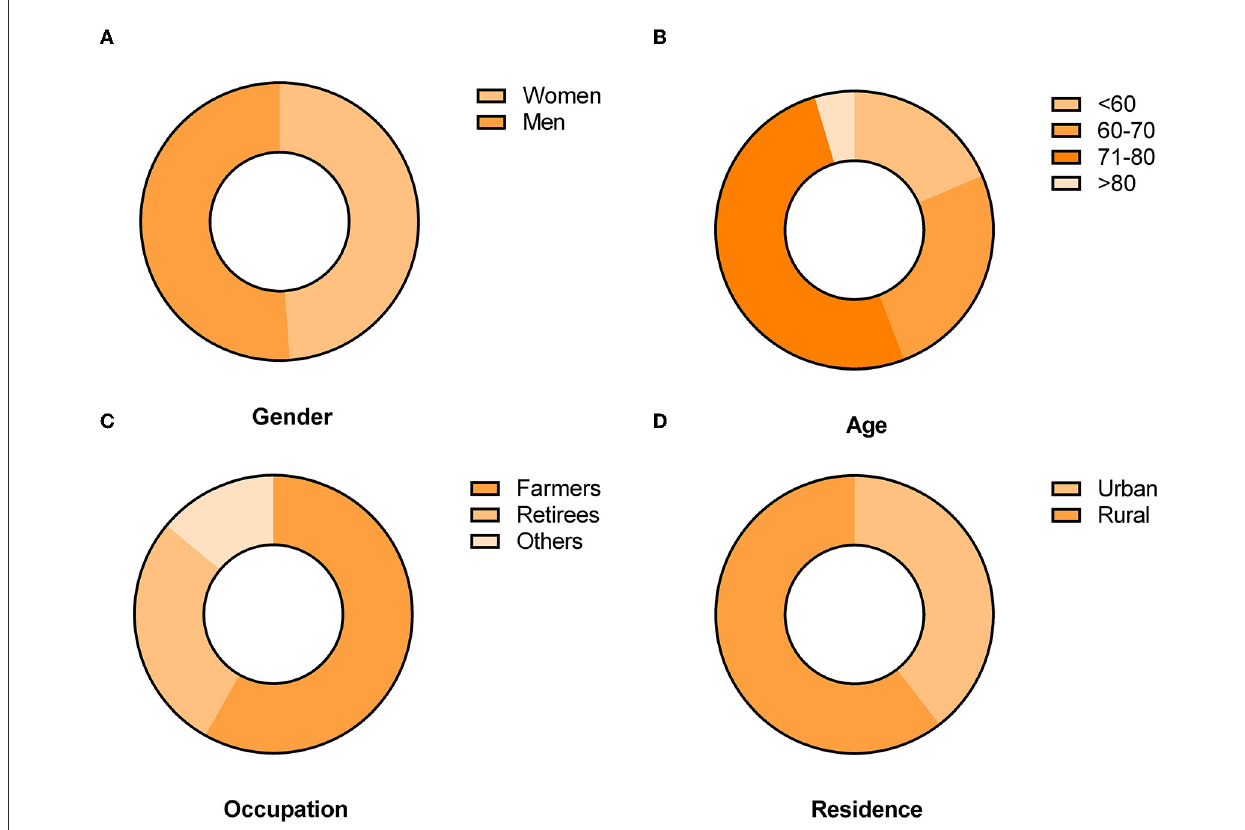
FIGURE3 Gender, age group, occupation, and residence distributions of the number of fatal cases of SFTS in Jiangsu province, 2011–2022. (A) Gender distribution of fatal SFTS cases. (B) Age group distribution of fatal SFTS cases. (C) Occupation distribution of fatal SFTS cases. (D) Residence distribution of fatal SFTS cases.